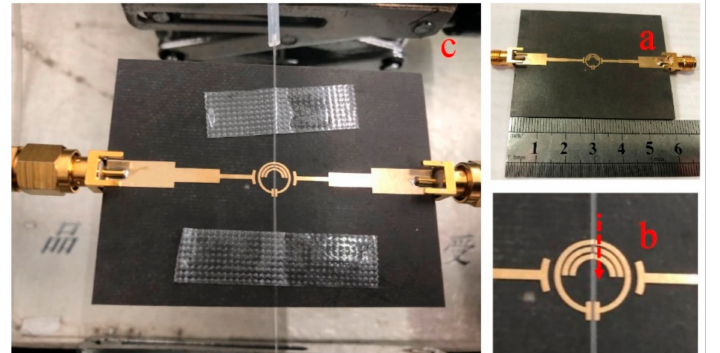
Figure 5. Assembled sensor system. ( a ) Fabricated microstrip coupled SRR with two SMA connectors; ( b ) Zoom-in view of the capillary channel attached to the sensing area. The channel is laid onto the SRR structure and the arrow indicates the flow direction; ( c ) Fully view of the assembled sensor with quartz tubes delivering liquid in the capillary channel and coaxial cables connected to the